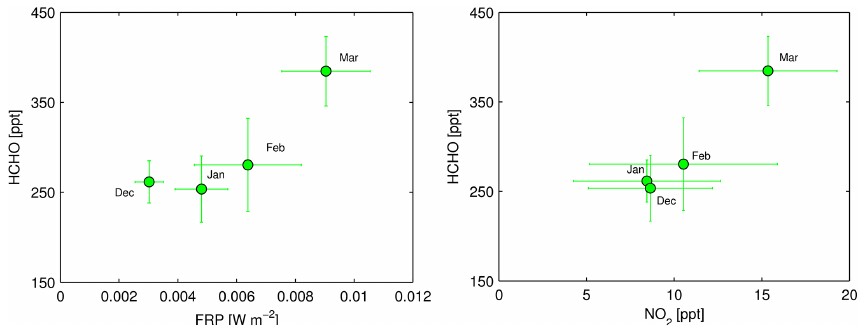
Figure 13. Multi-year-averaged (2004–2009) monthly means of X HCHO as a function of spatially averaged FRP over a selected region (see Table 3) (left) and multi-year-averaged (2004–2009) monthly means of X HCHO as a function of X NO deviation of monthly means is given (see Table